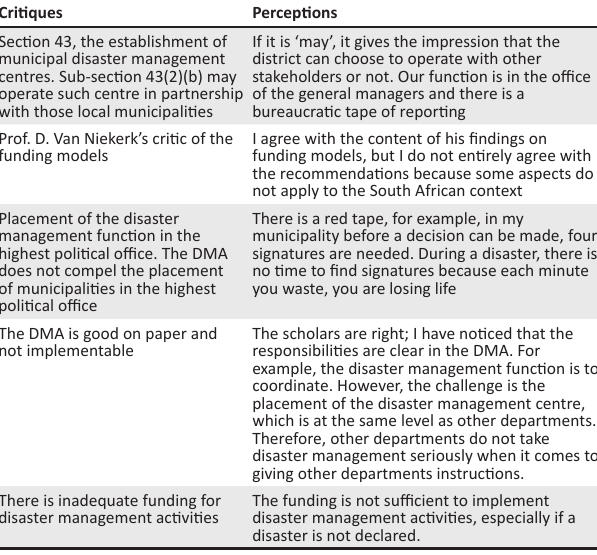
TABLE 2: Responses to the question, ‘Are you aware of scholars’ critique of the Disaster Management Act and the function?’